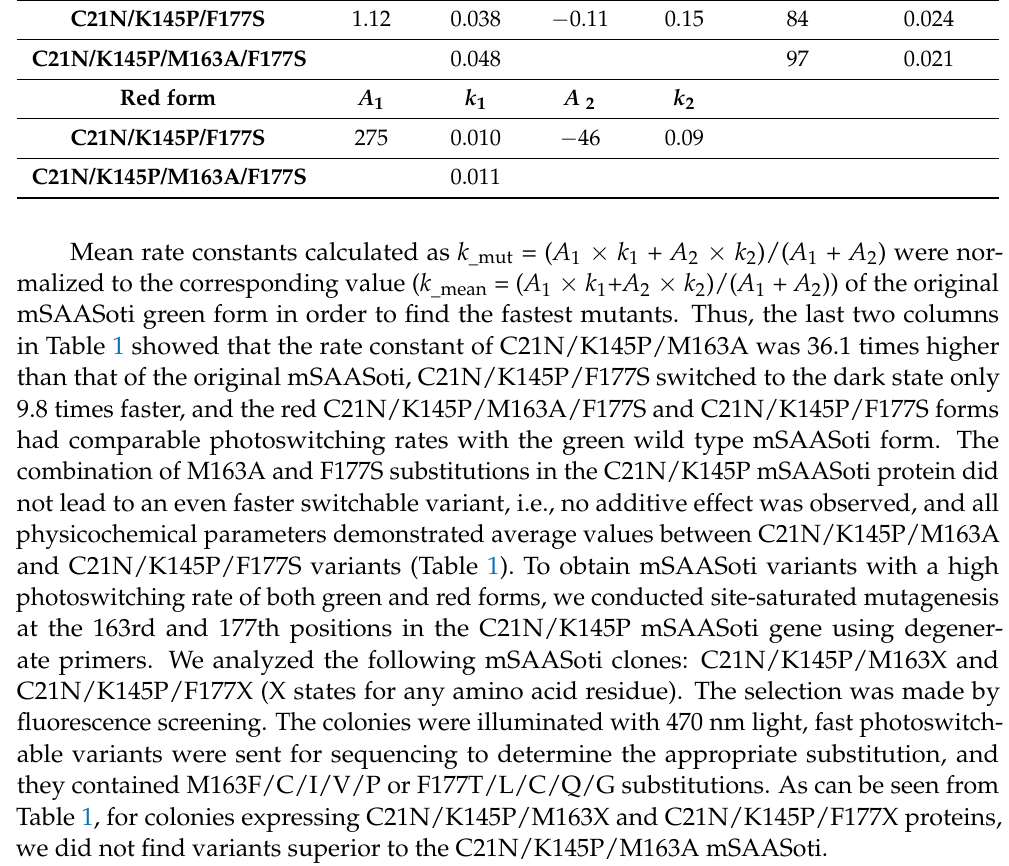
Table 1, for colonies expressing C21N/K145P/M163X and C21N/K145P/F177X